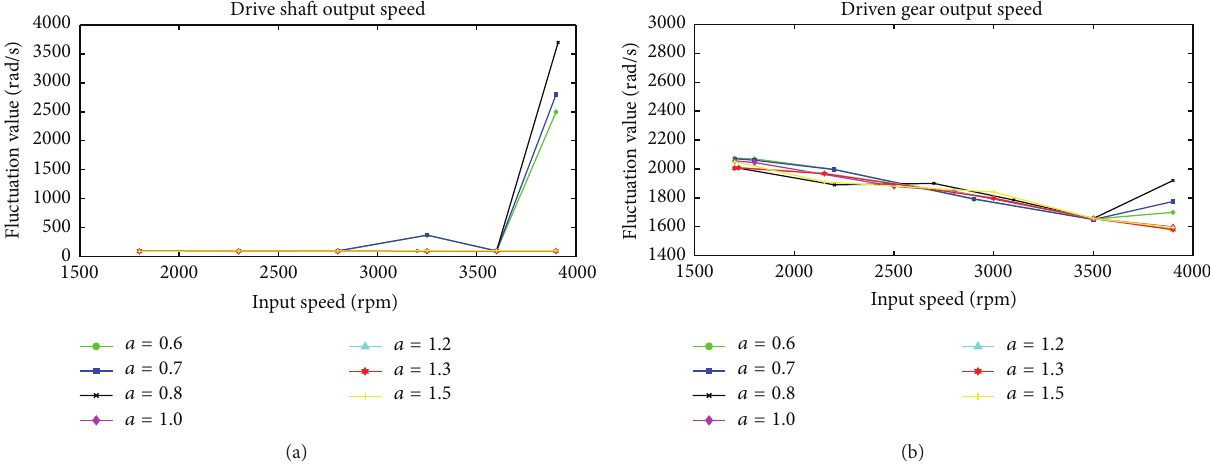
Figure 8: Speed fluctuations of the drive shaft and driven gear.